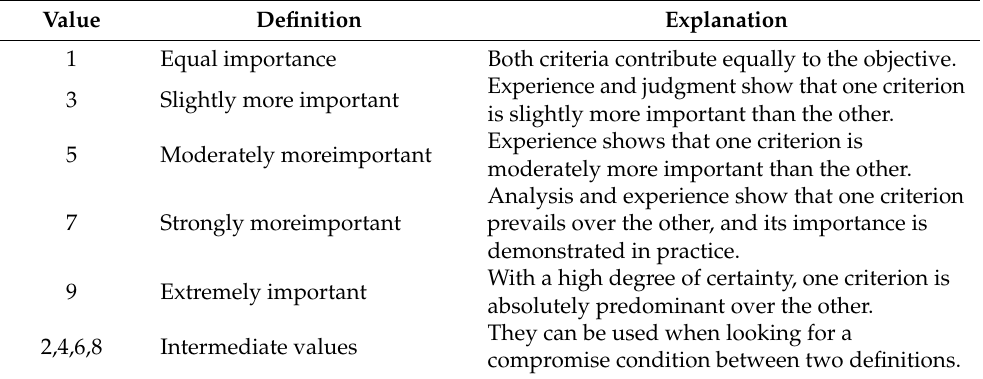
Table 3. Degree of importance of the AHP method criteria.